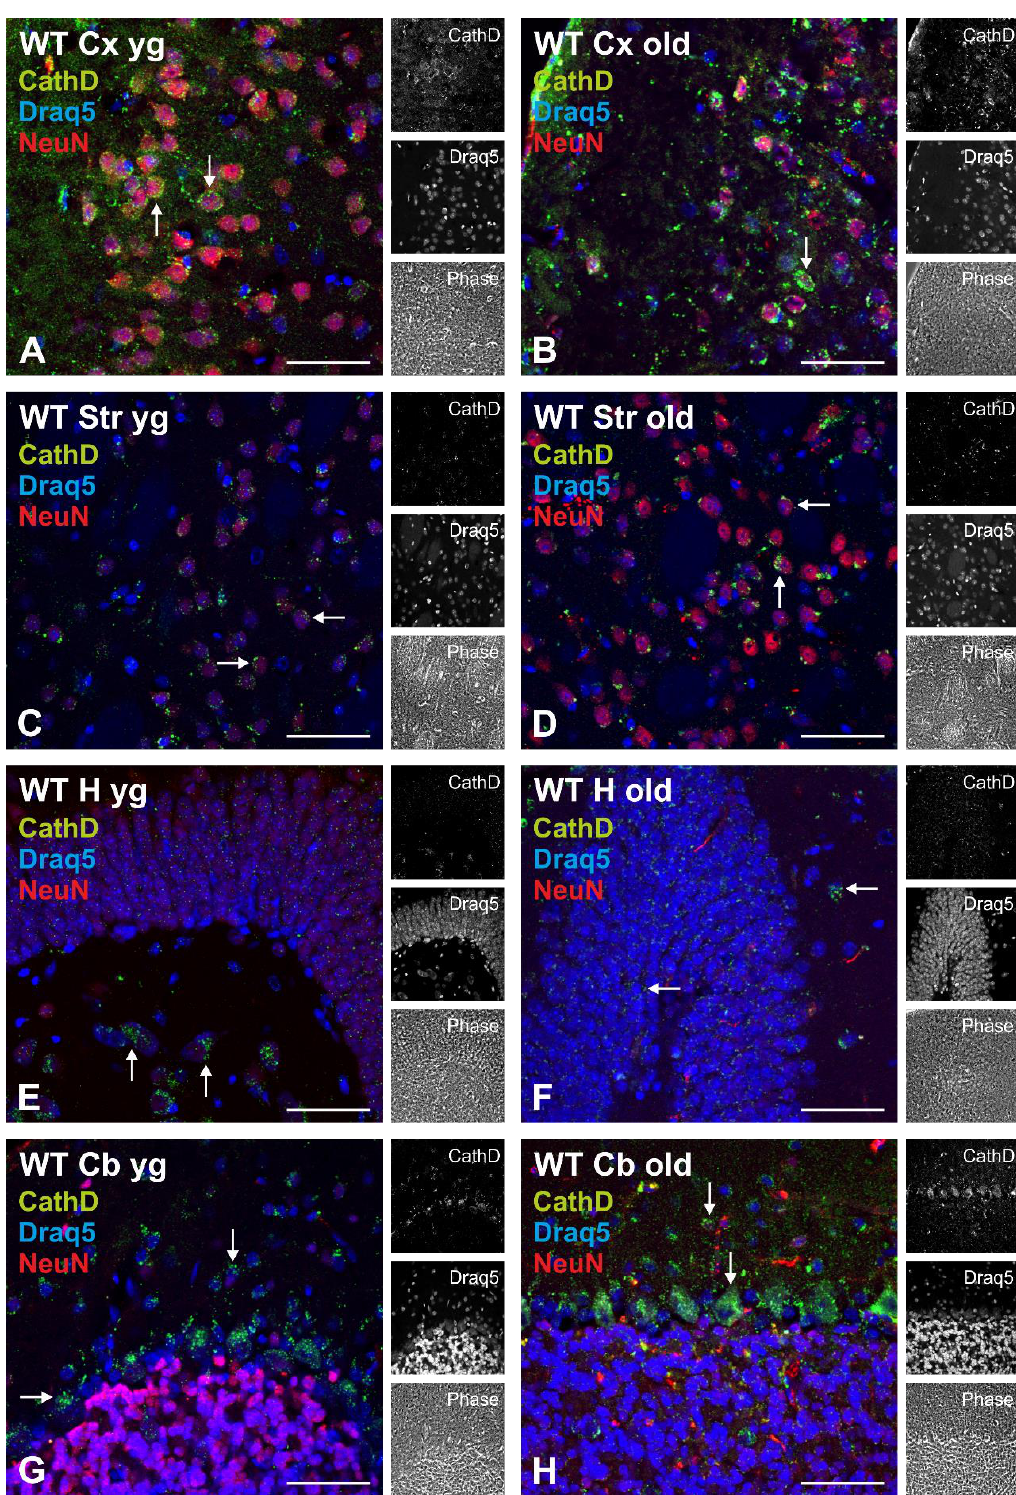
Figure 2. Distribution and localization of cathepsin D in the CNS of young and aged WT mice. ( A – H ) Cathepsin D localization in CNS of WT young ( A , C , E , G , 5 – 7 months old) and aged ( B , D , F , H , 18 – 20 months old) mice using confocal scanning microscopy (green, cathepsin D ; blue, Draq5™ nuclear stain; red, NeuN neuronal marker). Like cathepsin B, cathepsin D was localized in a vesicular pattern (arrows) in neuronal cells and other brain cells in cortex ( A , B ), striatum ( C , D ), hippocampus ( E , F ), and cerebellum ( G , H ). Scale bars: 50 µ